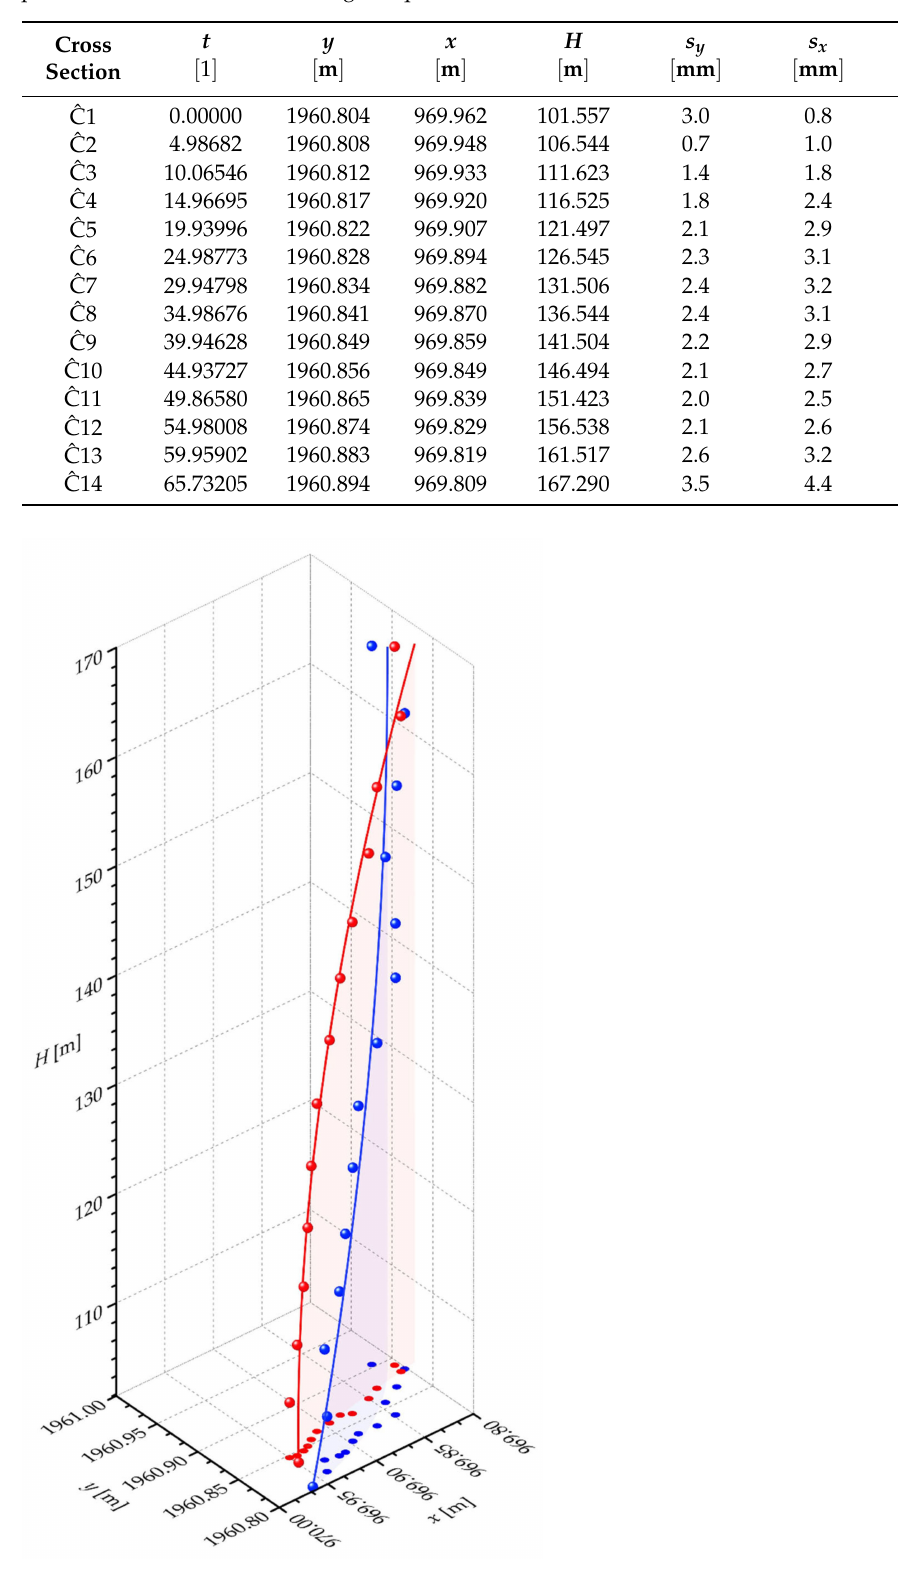
Table 12. Final regression results based on the validation UAS data set; parameter t defines the position of the cross section along the quadratic cure and determines its 3D coordinates.